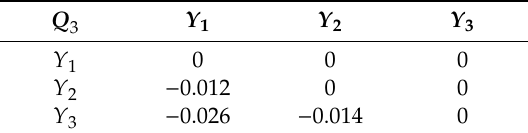
Table 6. The regret matrix Q 3 .